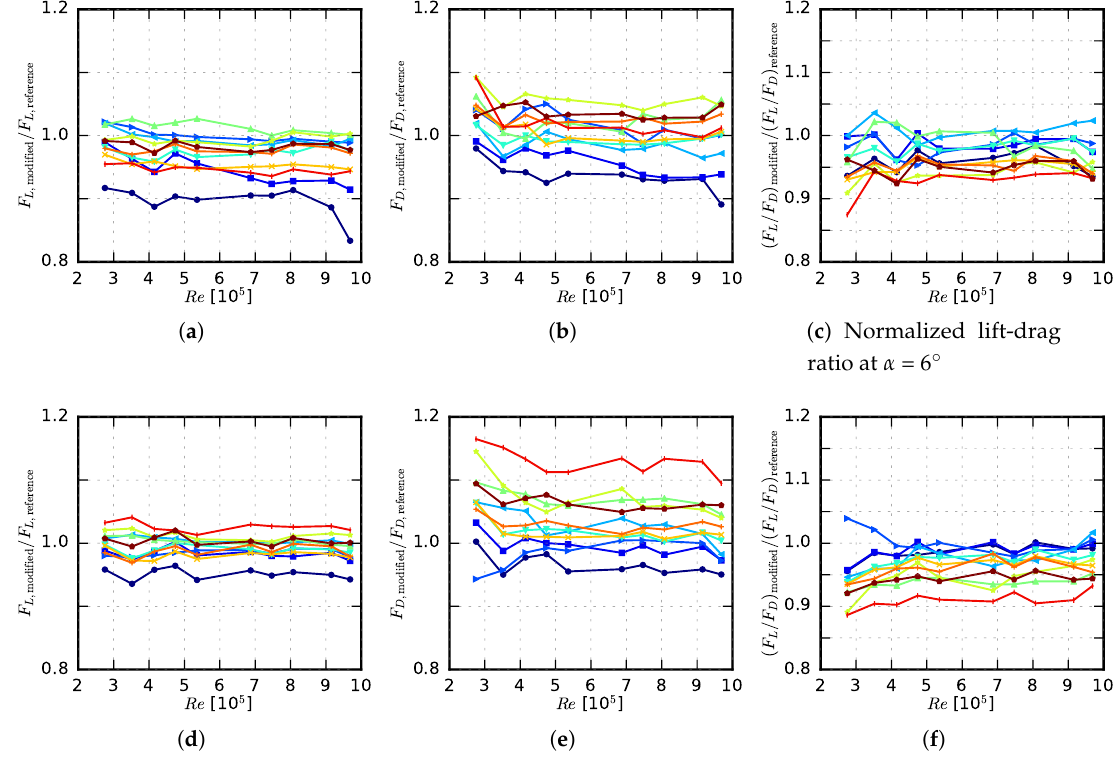
Figure 7. Aerodynamic forces of the airfoils with different leading edge comb structures, normalized with the corresponding values of the reference LS(1)0413 airfoil, PPS 12/2 turbulence grid (airfoil 1, 2, 3, 4, 5, 6, 7, 8, 9, 10, 11), ( a ) normalized lift force at α = 6 ◦ , ( b ) normalized drag force at α = 6 ◦ , ( c ) normalized lift-drag ratio at α = 6 ◦ , ( d ) normalized lift force at α = 12 ◦ , ( e ) normalized drag force at α = 12 ◦ , ( f ) normalized lift-drag ratio at α = 12 ◦